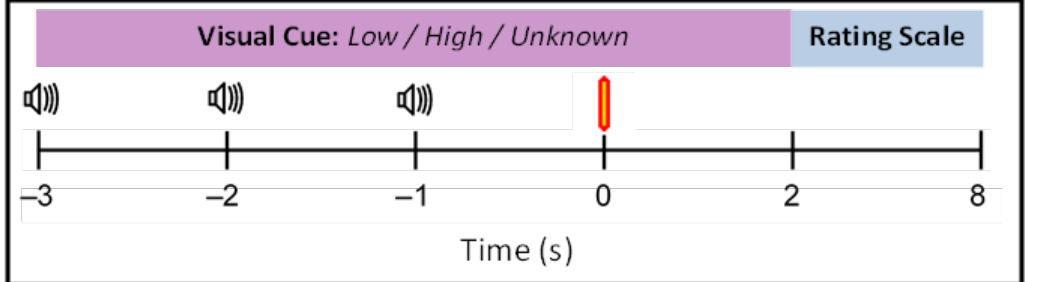
Figure 1. A schematic diagram of a single trial of the experimental paradigm. A computer monitor showed the participant a visual cue of “Low”, “High” or “Unknown” from − 3 s to +2 s. A 3-second countdown of auditory cues at − 3, − 2 and − 1 allowed accurate anticipation of the laser stimuli at time 0s (red bar). The presentation of the visual cue at − 3 s was concurrent with the first auditory cue. At +2 s, an 11-point numerical rating scale (NRS) was presented for the participant to rate the laser